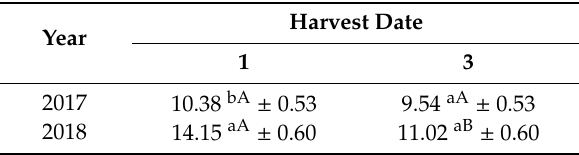
Table 3. Mean values ± standard error and significant di ff erences of the Fisher’s LSD test ( α = 0.05) for number of primary branches for the factor year (2017 and 2018) and harvest date (Harvest 1 (2017: 84, 2018: 82 DAS) and 3 (2017: 98, 2018: 96 DAS) (DAS, days after sowing). Mean values with at least one identical lowercase letter are not significantly di ff erent within a column. Mean values with at least one identical capital letter are not significantly di ff erent within a row.